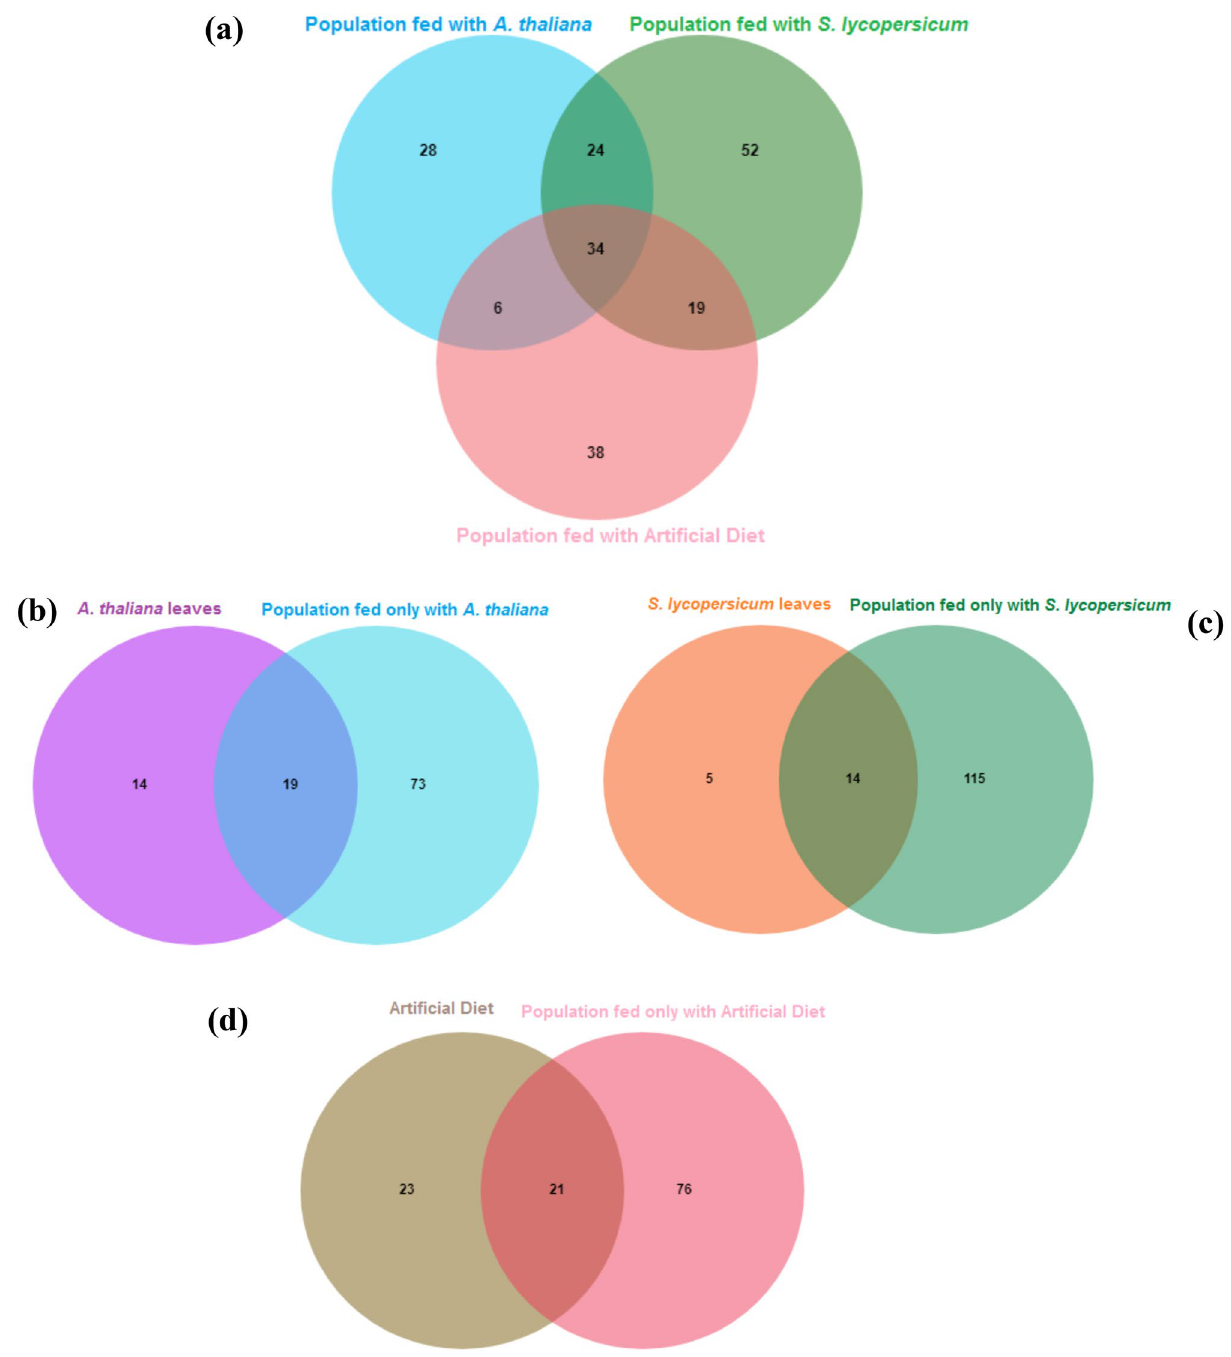
Figure 5. Venn diagrams showing distribution of shared and unique ASVs assigned at the genus level among the different T.ni populations fed with exclusive diets over four cycles. ( a ) Venn diagram showing common or unique ASVs among insects fed with A. thaliana leaves, S. lycopersicum leaves, or the artificial diet. ( b ) Common or unique ASVs detected in A. thaliana leaves and guts of the insect population fed with A. thaliana leaves. ( c ) Common or unique ASVs detected in S. lycopersicum leaves and guts of the insect population fed with S. lycopersicum leaves. ( d ) Common or unique ASVs detected in artificial diet and guts of the insect population fed with the artificial diet. leaves. The names data about the common or unique genera in all Venn diagrams are presented in Supplementary Table